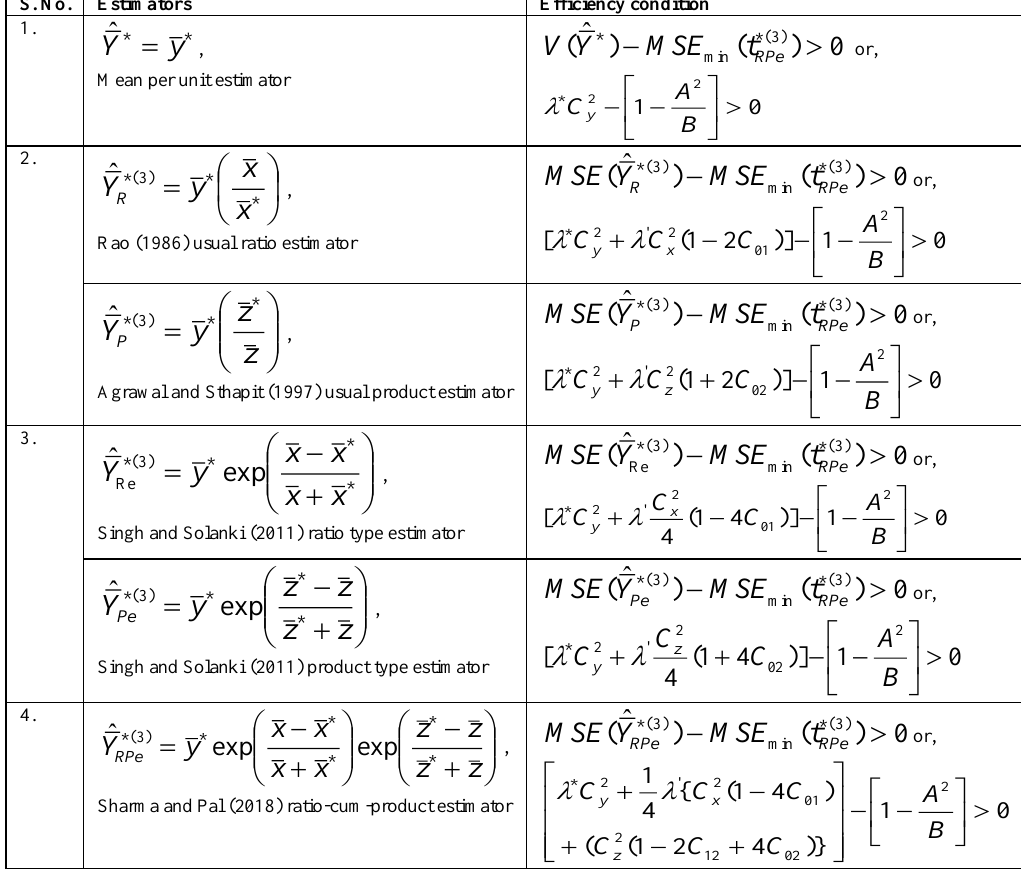
Table 6. Comparison with competing estimators under third strategy of non-response S.